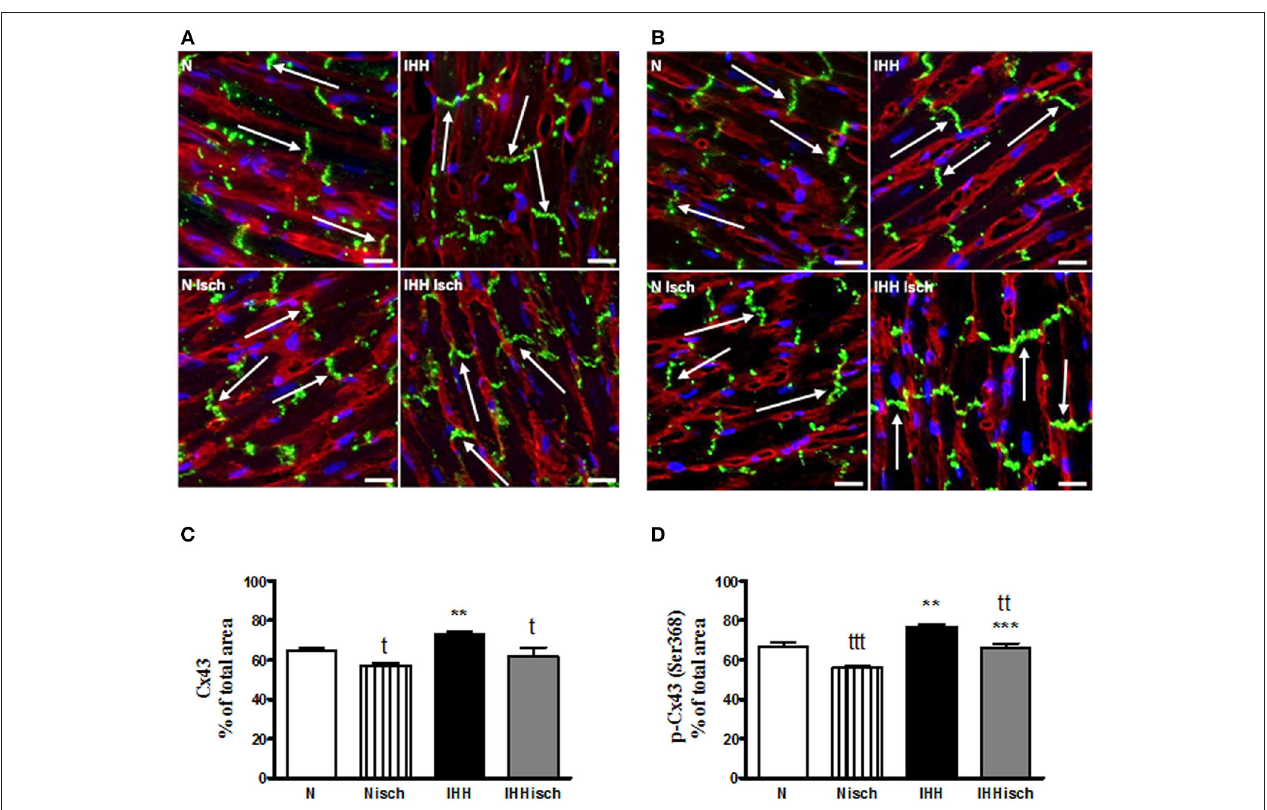
FIGURE 5 | Effect of chronic intermittent hypobaric hypoxia (IHH) on distribution of total Cx43. The representative micrograph of longitudinal cryosections demonstrates distribution of t-Cx43 (A) and p-Cx43(Ser368) (C) after 10-min regional ischemia in normoxic (N Isch) and hypoxic (IHH Isch) left ventricular myocardium compared to control groups not subjected to ischemia (N, IHH). The green color corresponds to specific Cx43 staining, red color represents sarcolemma (counterstained by WGA) and the blue color indicates nuclei DAPI staining. Note the positive Cx43 staining (arrows) located predominantly at the intercalated discs, i.e., “end to end” junctions of the cardiomyocytes. The proportion of t-Cx43 and p-Cx43(Ser368) at “end to end” junctions in normoxic (N) and hypoxic (IHH) groups under control conditions and after ischemia (Isch) (B,D) is expressed as a percentage of total junctions. Values are mean ± SEM, ( n = 6 in each group), * vs. corresponding normoxic group; t vs. corresponding non-ischemic group; t P ≤ 0.05, **/ tt P ≤ 0.01, ***/ ttt P ≤ 0.001. Scale bar represents 20 µ m.